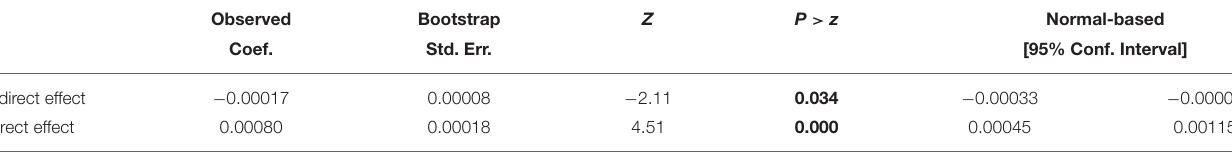
TABLE 13 | Bootstrap test of the mediating effect of physical health in the impact of air pollution on depression. Observed Bootstrap Z P > z Normal-based Coef. Std. Err. [95% Conf. Interval]